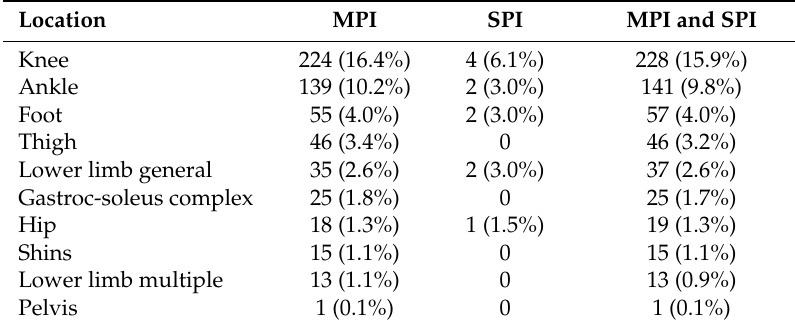
Table 2. Nature of injuries of knee injuries in Australian Army Reserve (ARES) personnel. Nature of Injury MPI SPI Soft tissue injuries (trauma or unknown mechanisms) 181 (80.8%) 0 Trauma to joints and ligaments 16 (7.1%) Contusion/bruising and superficial crushing Laceration